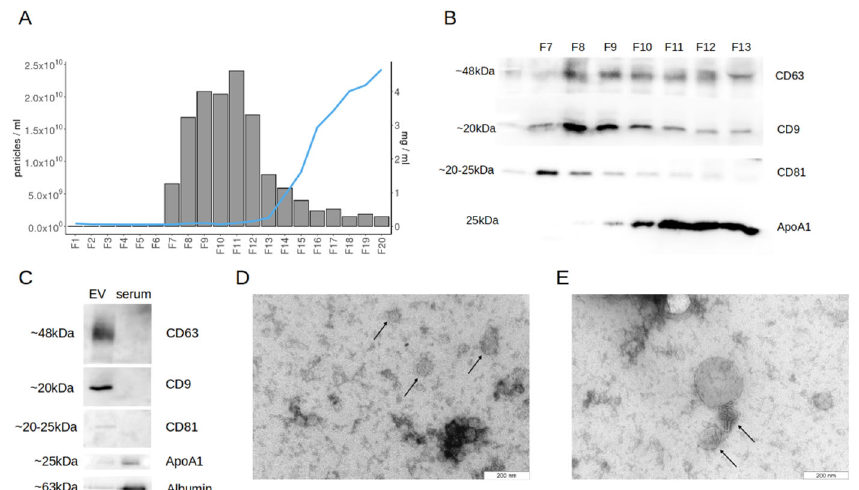
Figure 1. Purification and confirmation of blood serum EVs. ( A ) Elution profile of differentially centrifuged and qEV original 70 nm size-exclusion chromatography (SEC) purification of blood serum EVs in across 500 µ L fractions. Consecutively collected fractions are presented on the x -axis, while bars represent the nanoparticle concentration (particles/mL) per fraction, and the blue line marks protein concentration (mg/mL) across fractions. ( B ) Western blotting analysis for relative abundance of EV-specific surface markers (CD63, CD9, and CD81) and ApoA1 as the major component of HDL particles in the nanoparticle-rich SEC fractions. Equal volumes of concentrated EV samples were used as the input in case of the tetraspanins, while the input was diluted 10-fold for ApoA1. ( C ) Comparative Western blotting of EV-specific surface markers and ApoA1 in the purified EV samples in contrast to unprocessed blood serum with total protein concentration adjusted to be equal for both samples for each target protein. ( D , E ) Transmission electron microscopy imaging of purified EV samples. Black arrows highlight spherical particles with size and morphological characteristics inherent to EVs.